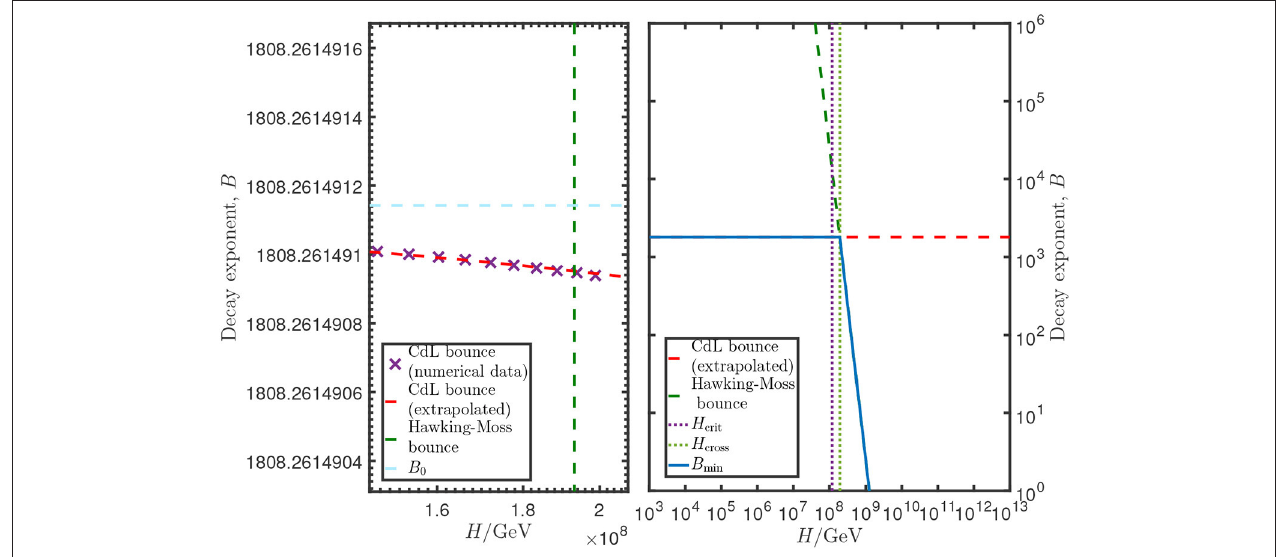
173.34GeV, M h 125.15 = =